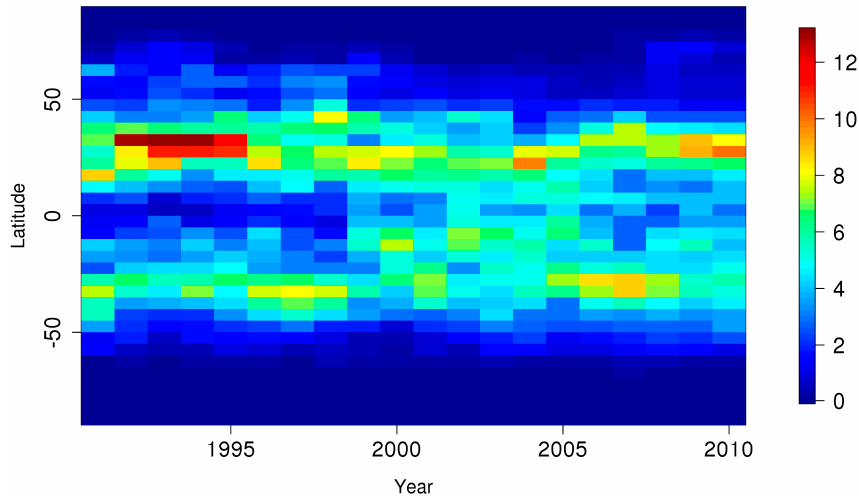
Figure 2. Percentage of drifting buoy match-ups available per 5° latitude band calculated annually.